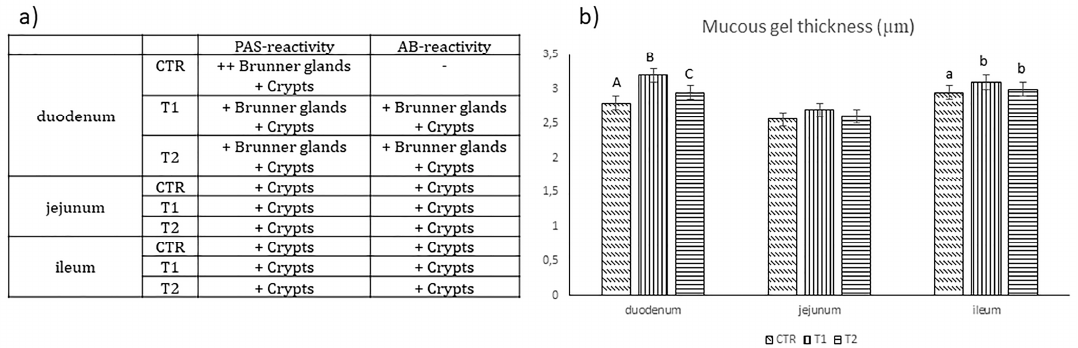
Figure 3. ( a ). Qualitative evaluation of the neutral and/or acidic glyconjugates; ( b ) the histometrical findings of the mucus gel thickness in the duodenum, jejunum and ileum of CTR, T1 and T2 animals (CTR—control diet; T1—sunflower oil supplemented diet; T2—sunflower oil supplemented diet plus verbascoside). The values are shown with different superscripts ( a , b ) for p < 0.05 and (A, B) for p < 0.01.